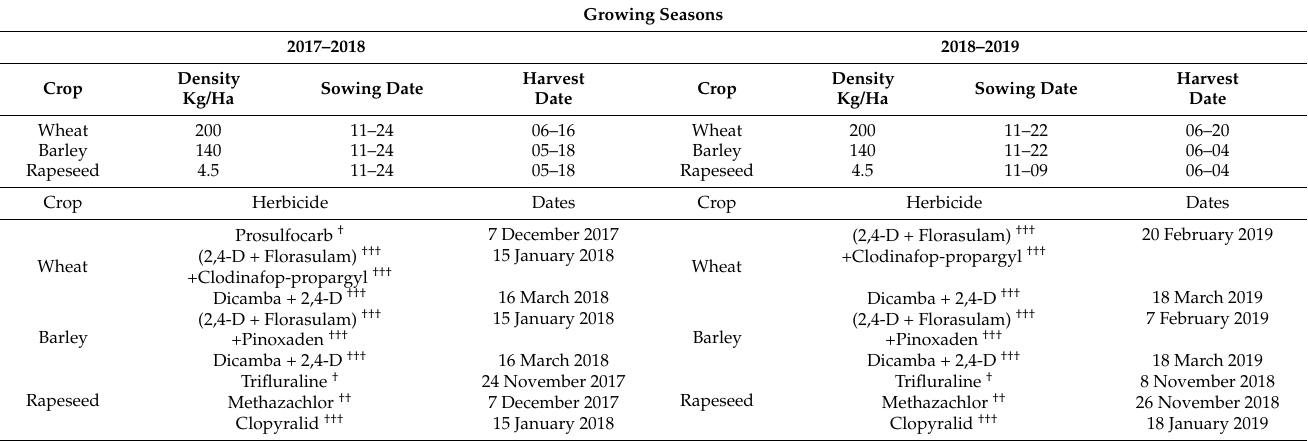
Table 1. Management practices (crops and herbicides) during the two growing